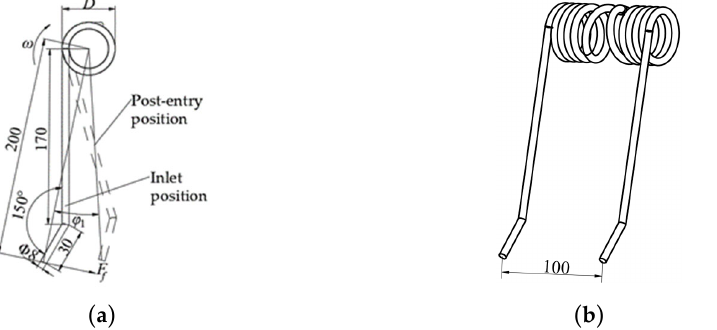
Figure 5. A schematic diagram of the hook tooth structure: ( a ) Diagram of the influence of resistance of hook teeth into the soil; ( b ) Axonometric drawing.